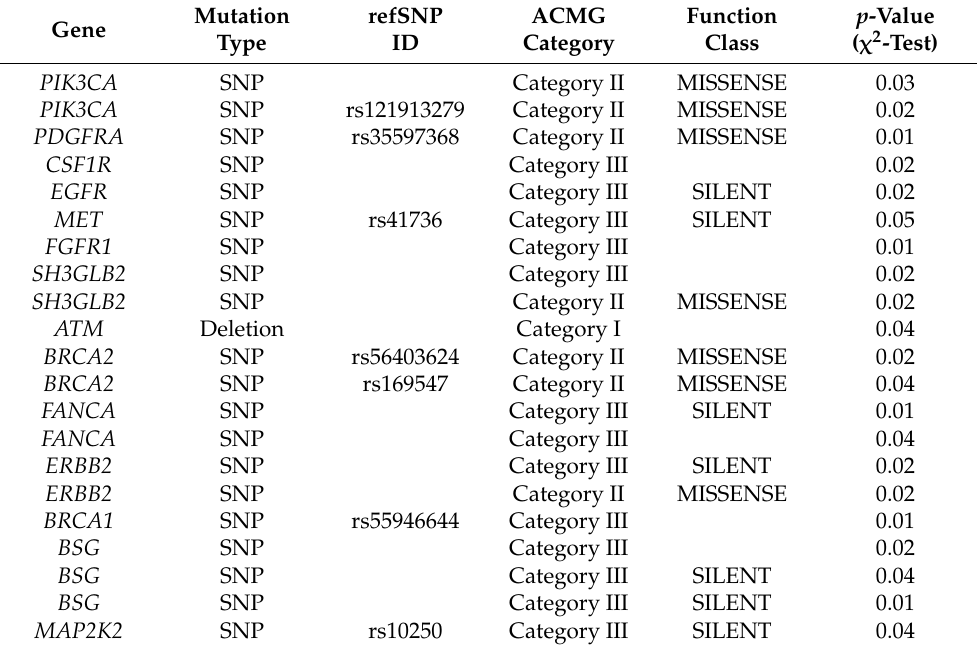
Table 3. Variants significantly mutated between the predicted high- and low-risk group of Taiwanese breast